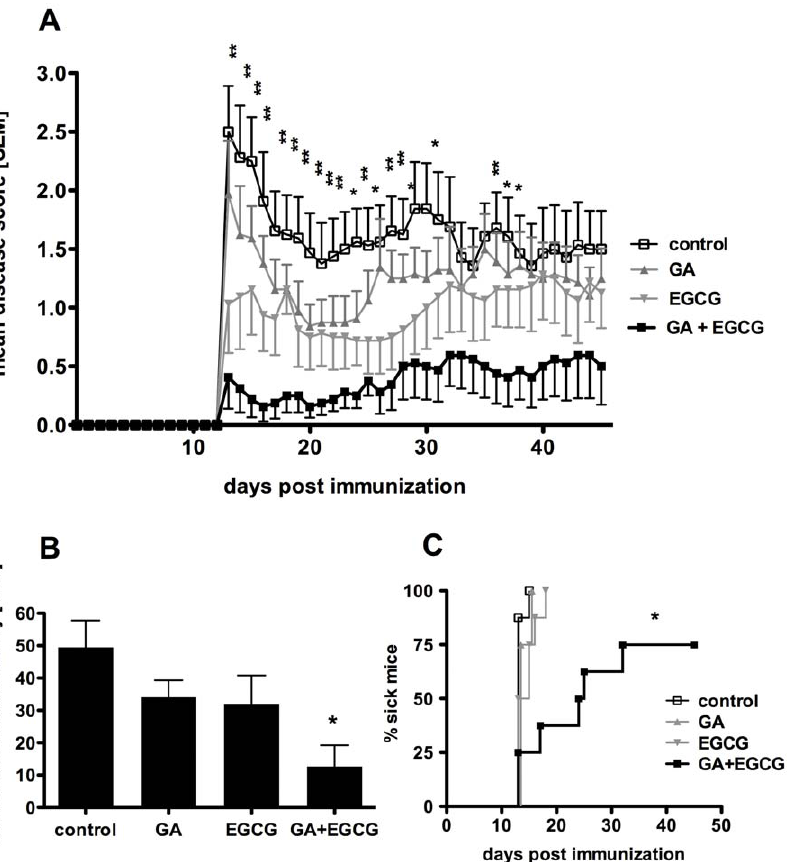
Figure 3. Combination therapy with EGCG and GA delays disease onset and synergistically reduces EAE severity. For preventive treatment EGCG (300 m g) or vehicle (NaCl 0.9%) was administered orally twice daily from day 2 9 before immunization with PLP 139–151 until day 45. GA (50 m g) or vehicle (Mannitol 4%) in incomplete Freund’s adjuvant was given s.c. once on day 2 7 before immunization. Mean disease score of control, EGCG, GA and the combination therapy group is shown from day 0 to day 45 after immunization (A), * p , 0.05 day 13,15–18,20–22,24,26–27, **p , 0.01 day 14,19,23,25,28,35–39,42, n=8 per group. Onset of disease in control, GA, EGCG and combination therapy group is presented in a Kaplan-Meier survival curve as percentage of sick mice at a certain day after immunization (B), *p , 0.05. Cumulative disease activity of control, GA, EGCG and combination therapy group was calculated as the area under the curve of the clinical score plots for each individual animal (C), *p , 0.05.